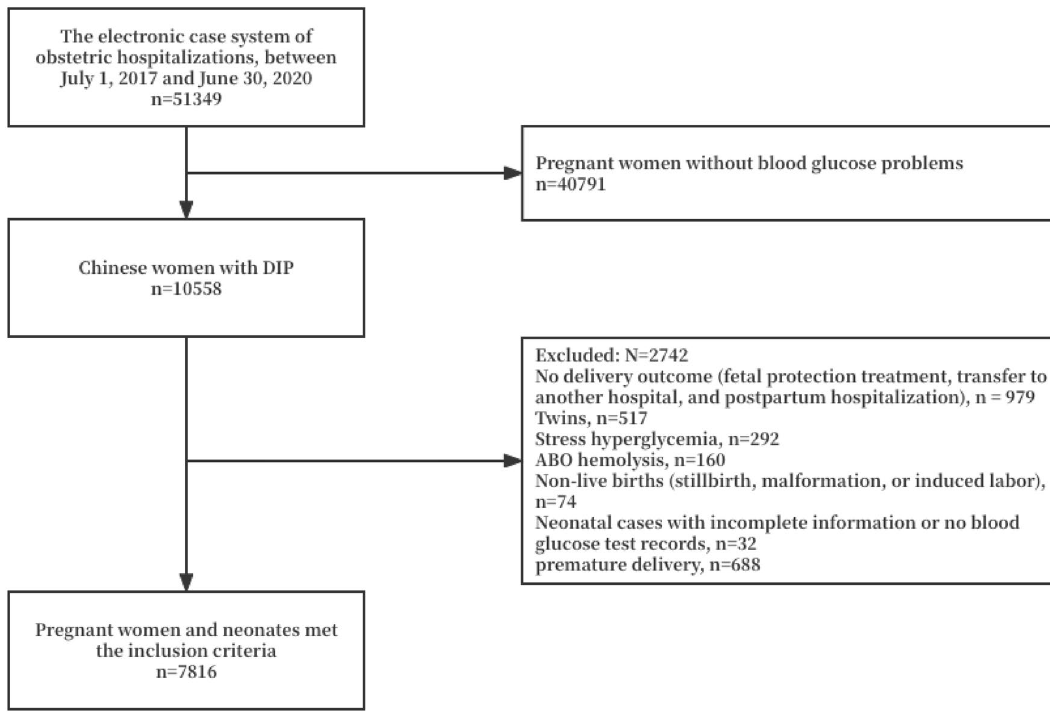
Figure 3. Flow chart for study